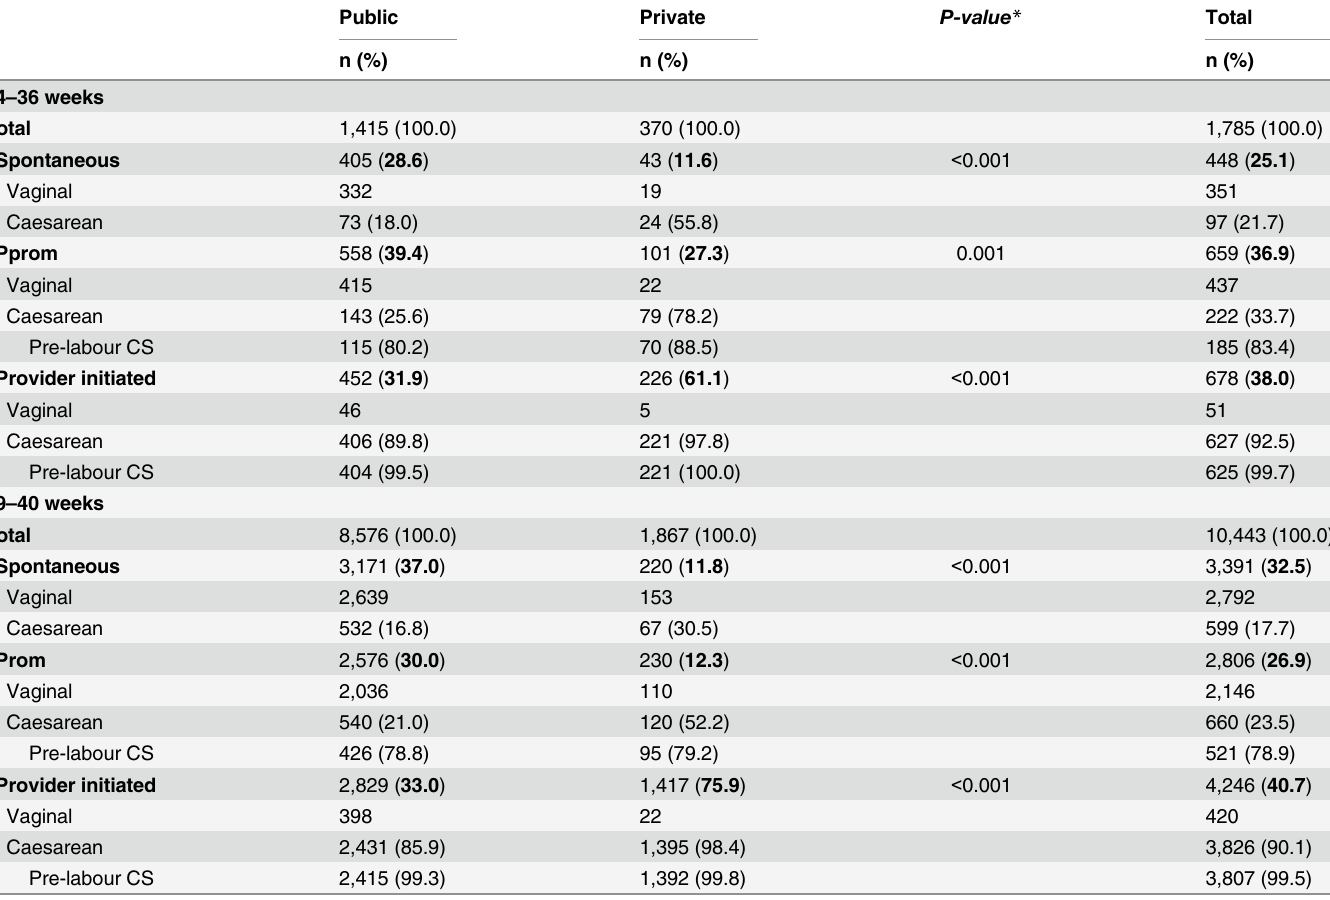
Table 2. Determining factor and type of delivery by gestational age and type of childbirth care in singleton live births. Birth in Brazil, 2011 –